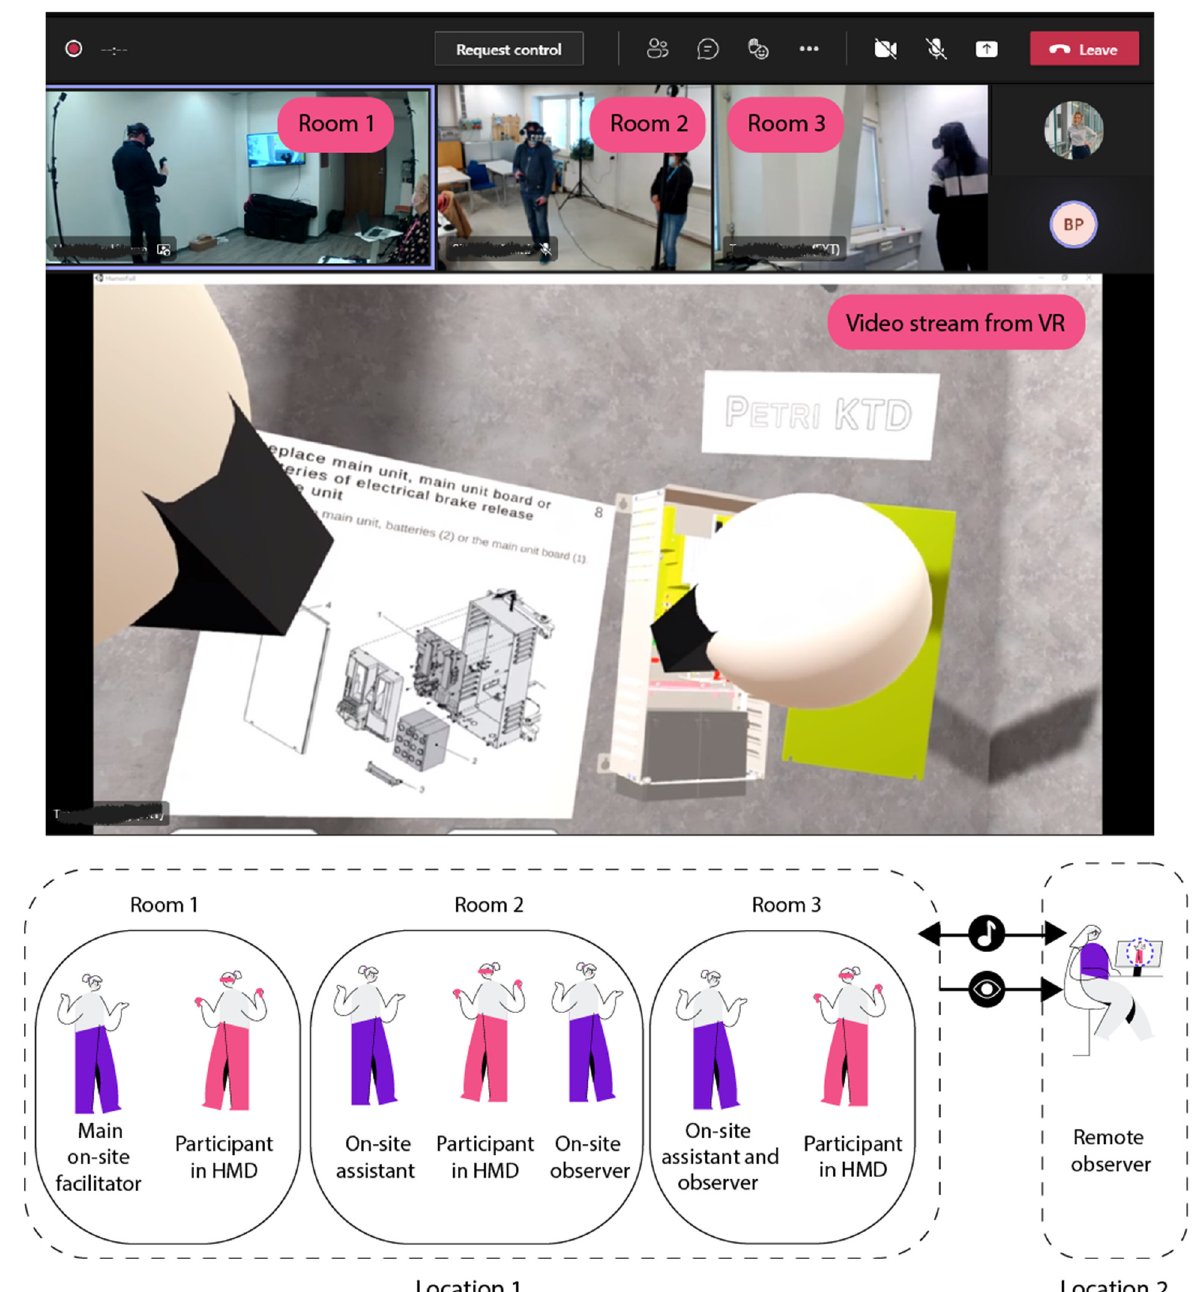
Figure 4. User study setup, showing both the video streams in Teams and the setups of the rooms and